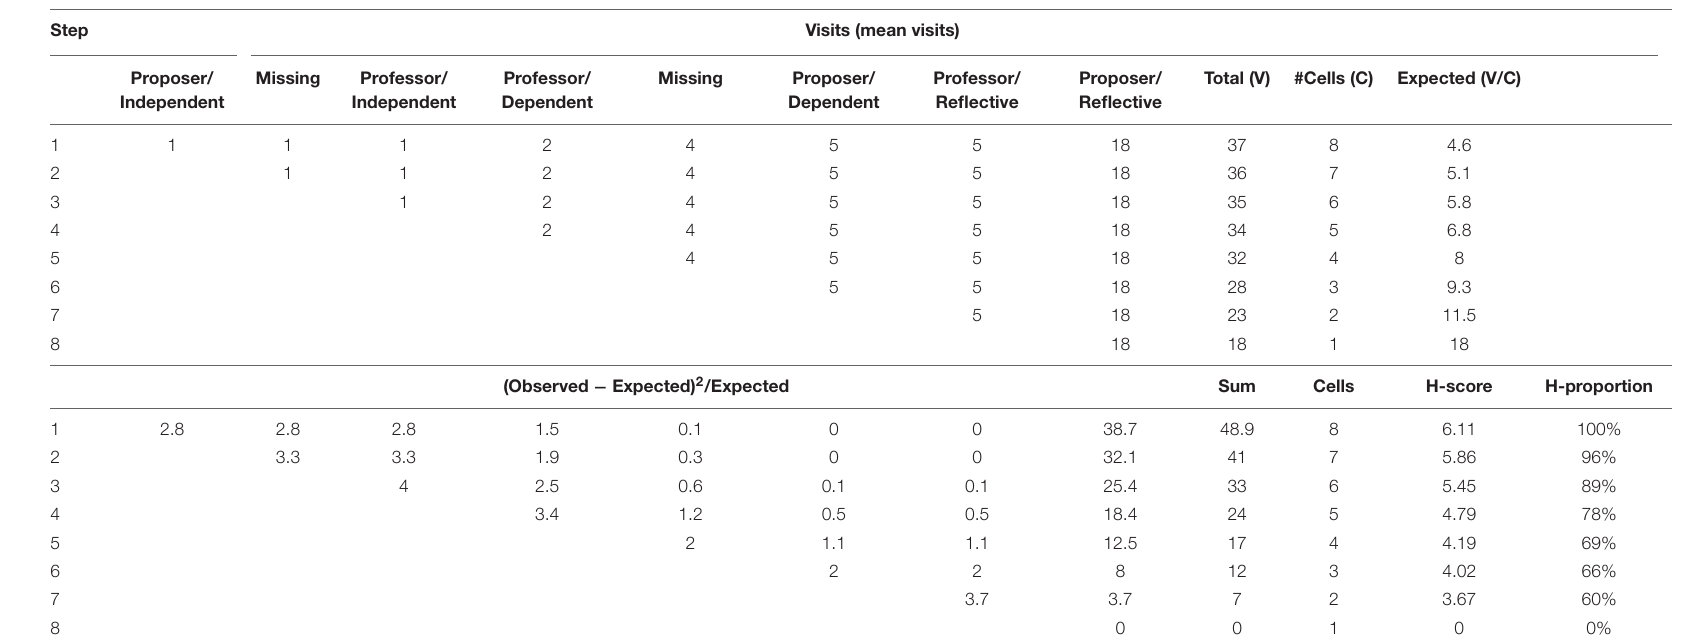
Cell “proposer/reflective” is identified as a hypothetical